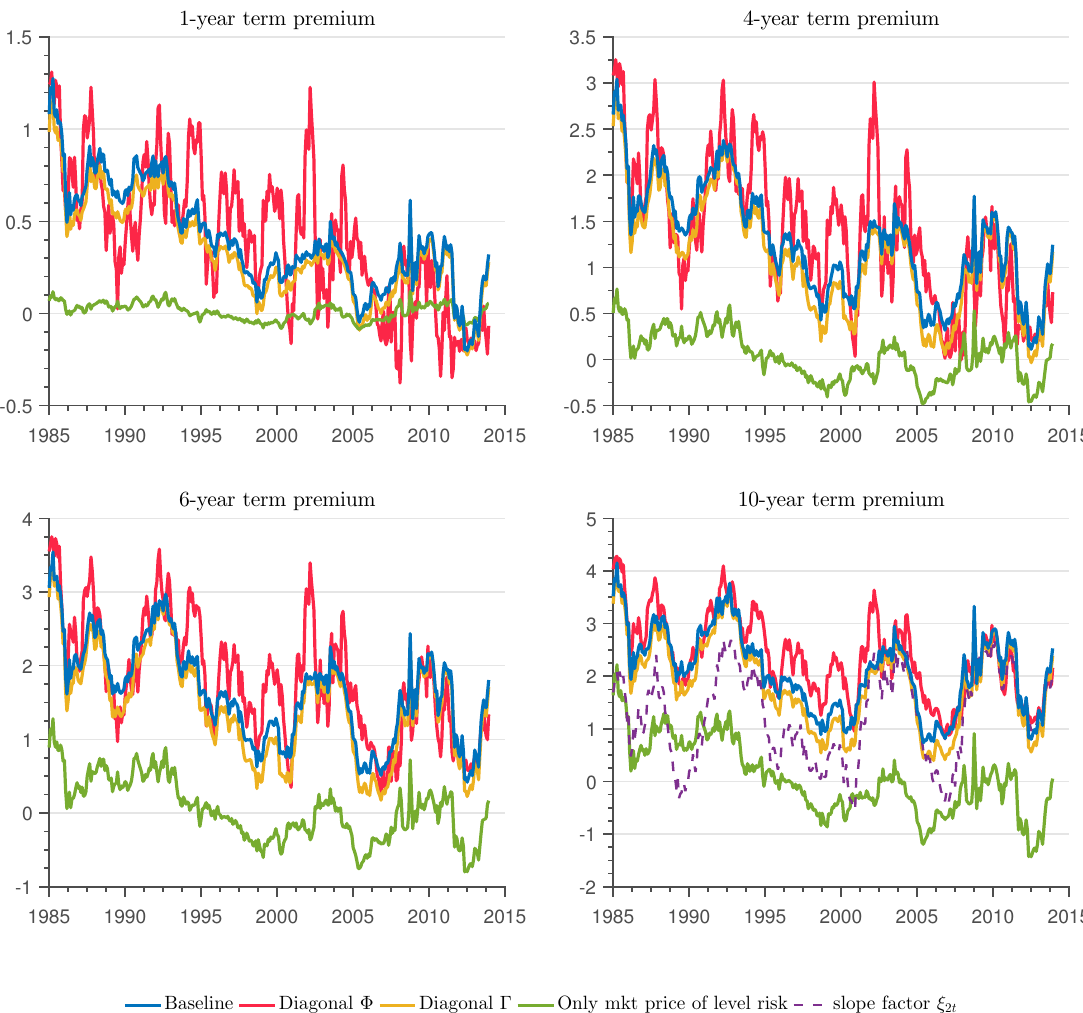
Figure 6. Term premium: different models and